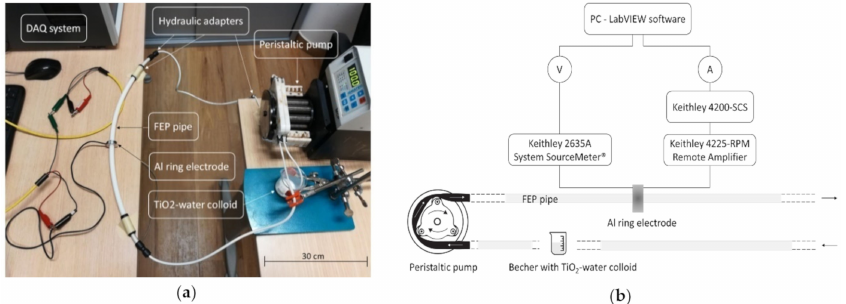
Figure 1. ( a ) Picture of the experimental setup with a focus on the capacitive electrode; ( b ) schematic of the experimental setup where all the components are highlighted.